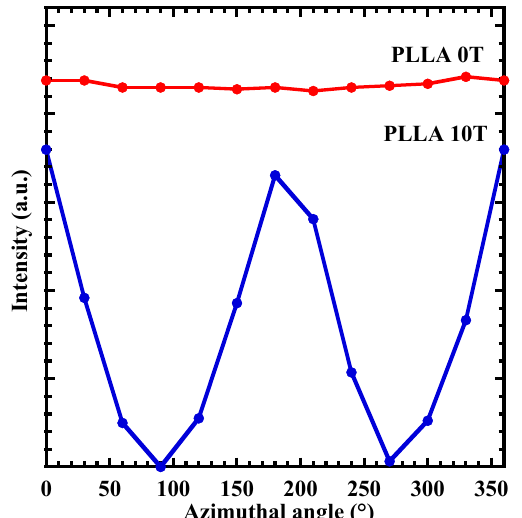
Figure 2. XRD (110)/(200)intensity along the azimuthal angle for PLLA0T and PLLA10T.